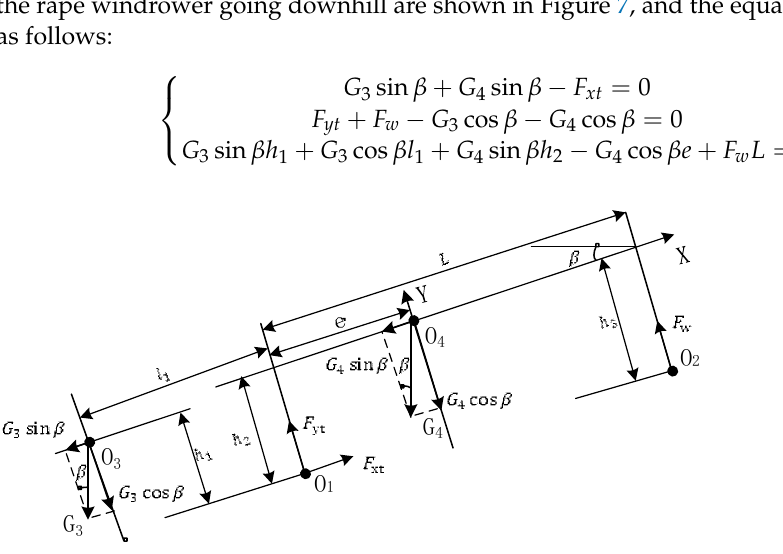
Figure 7. Force schematics of the rape windrower when driving down the slope.